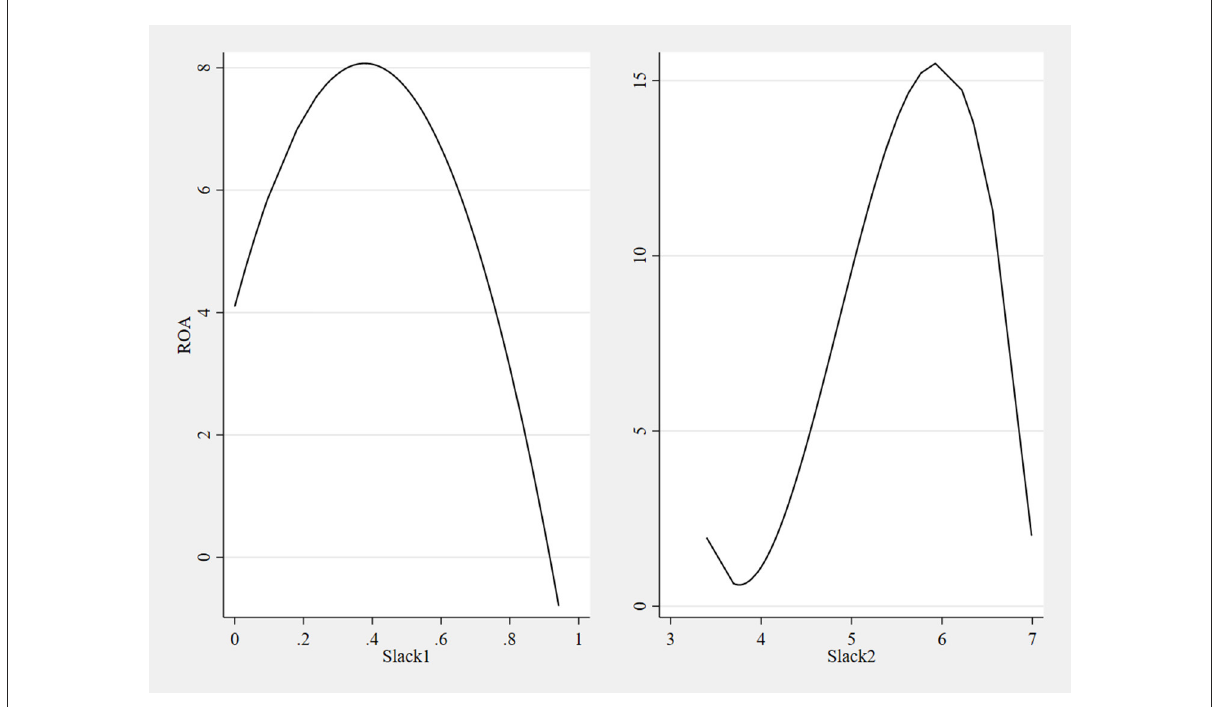
FIGURE2 Regression fit plots for models